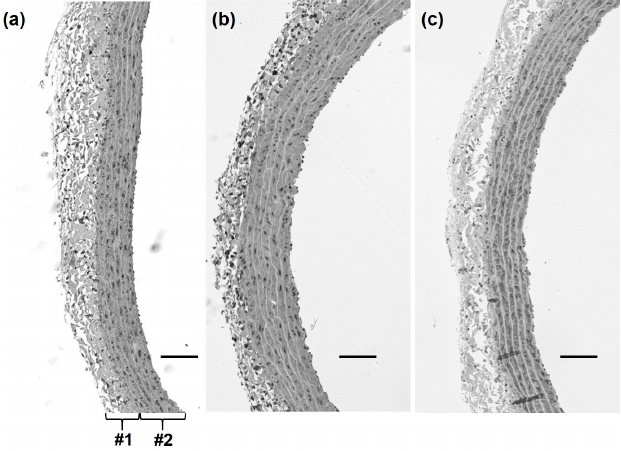
Figure 4. Representative histological alpha smooth muscle actin-stained images of the thoracic aorta of rats in the ( a ) Wistar Kyoto rat; ( b ) spontaneously hypertensive rat (SHR)-control; and ( c ) SHR- Eucommia leaf extract (ELE) groups. #1: arterial wall; #2: arterial media; scale bars = 100 μ m.